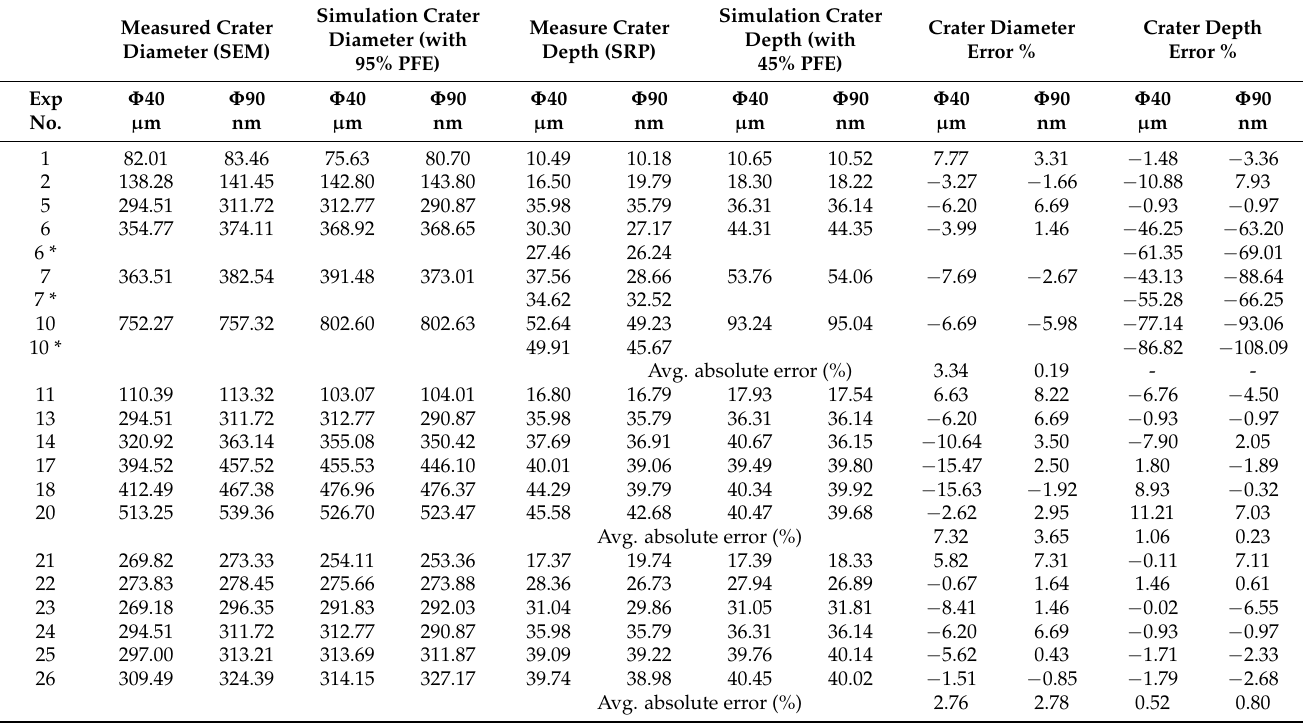
Table 4. Comparison of experimental and simulated